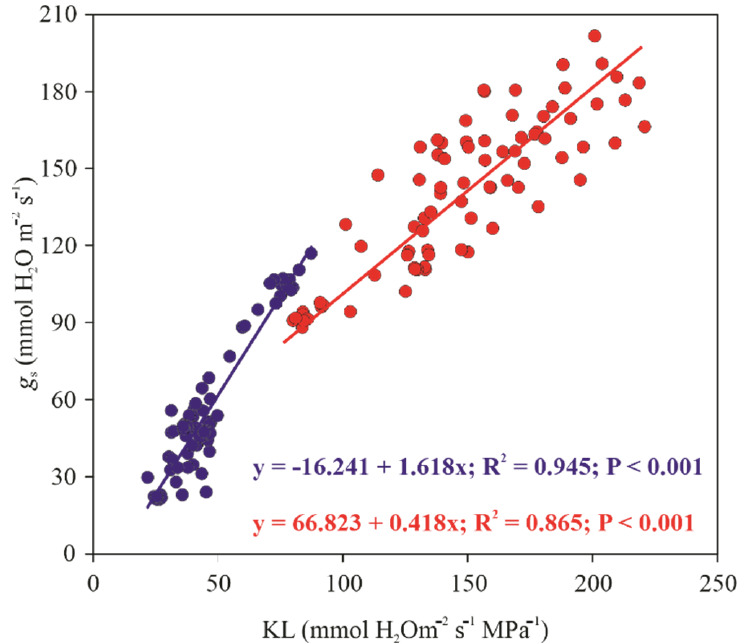
Figure 8. Relationship between leaf hydraulic conductance (KL) and stomatal conductance ( g s ) in sugarcane varieties in dry (blue symbols) and rainy (red symbols) seasons. Regression coefficient ( R 2 ) and p -value are shown.